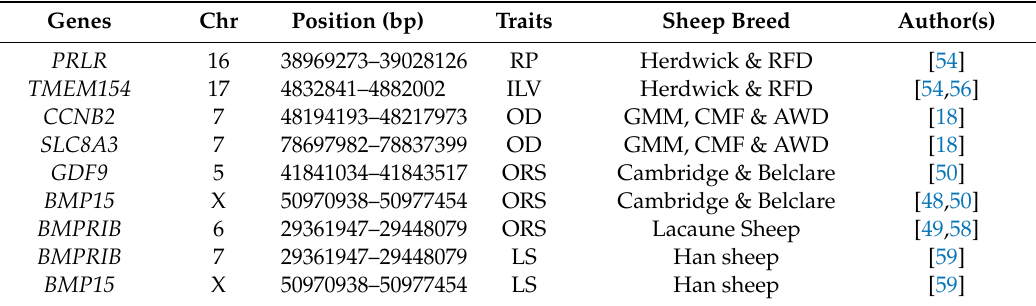
Table 3. Candidate genes for fertility traits and their